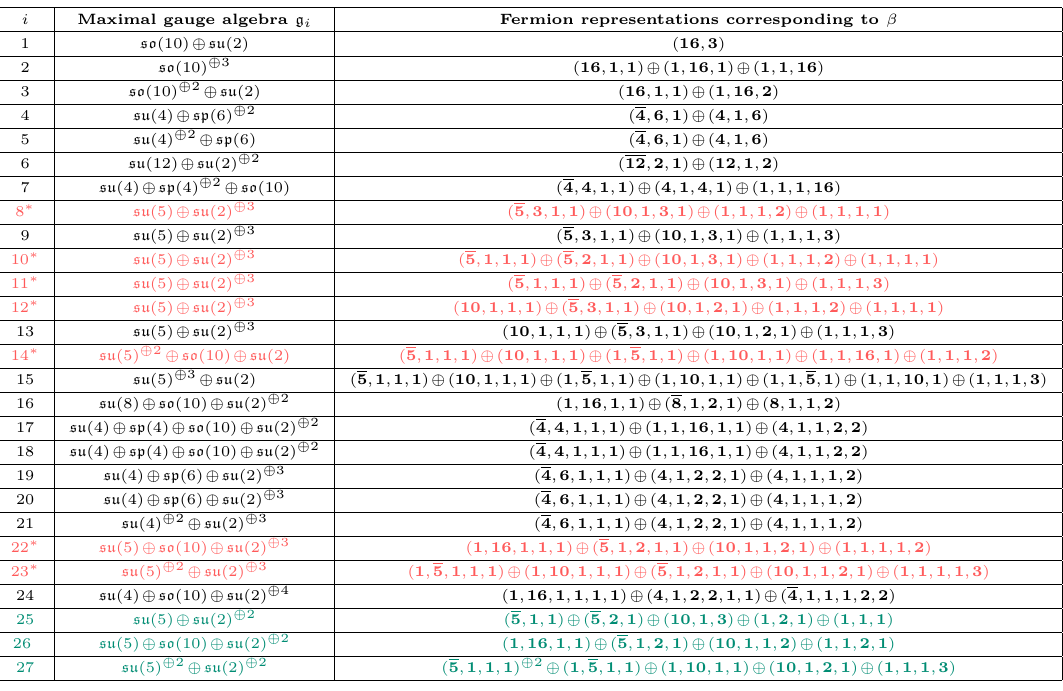
Table 1 . The complete list of maximal gauge algebra extensions of the SM, assuming no fermion content beyond the SM+ 3 ν . Rows 1–24 are reproduced from ref. [25]. Those algebras which neces- R sarily suffer from global gauge anomalies (in all cases these are associated with odd numbers of su (2) doublets) are highlighted with an asterisk, and coloured in red. Local gauge anomaly cancellation was already taken care of in producing the list of ref. [25]. The algebras 25-27, coloured in green, become maximal only when considering gauge algebras for which there are corresponding